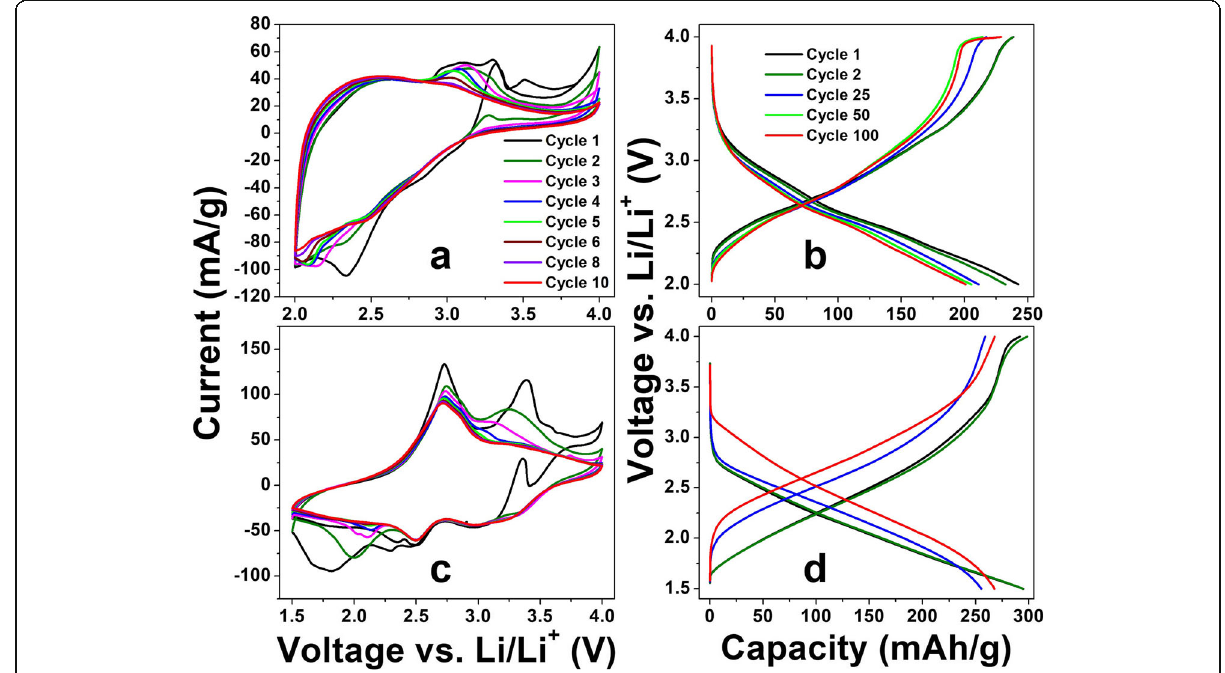
Fig. 4 Li-ion battery CV curves ( a , c ) and GC profiles at 0.1 C ( b , d ) of a-VOx-6